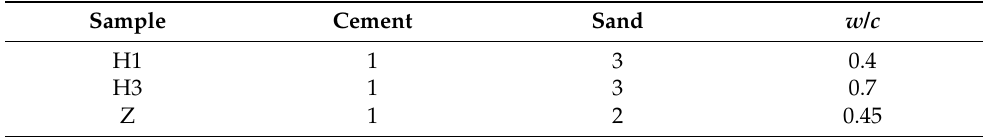
Table 1. Mix proportions of mortar, where H and Z indicate specimens for dynamic tests and microstructural observation, respectively.